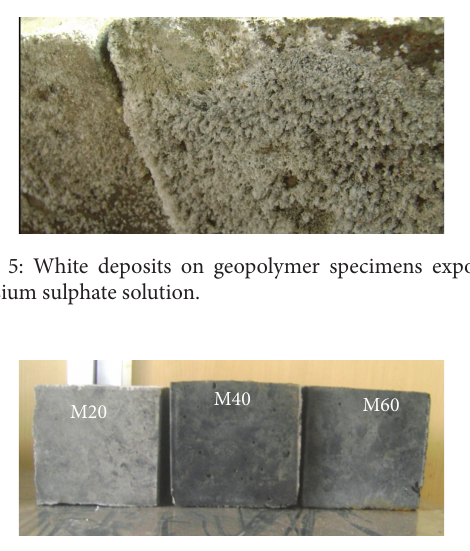
Figure 6: OPC specimens exposed to magnesium sulphate and sulphuric acid solution.